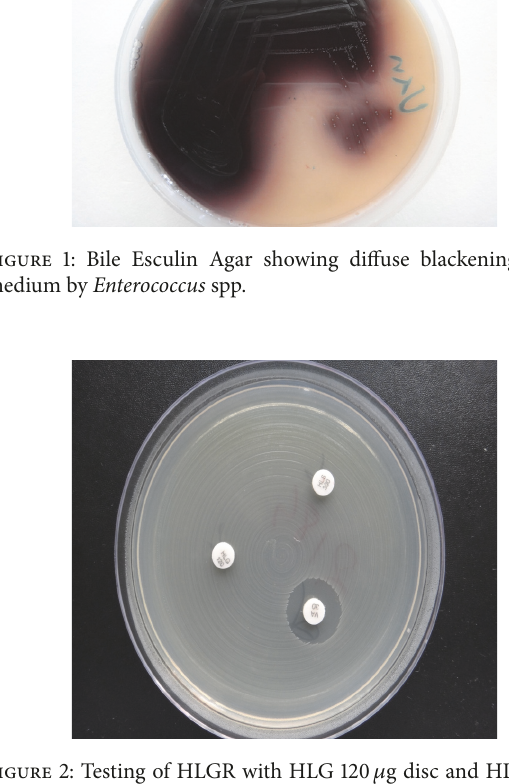
Figure 2: Testing of HLGR with HLG 120 𝜇 g disc and HLSR with HLS 300 𝜇 g disc.